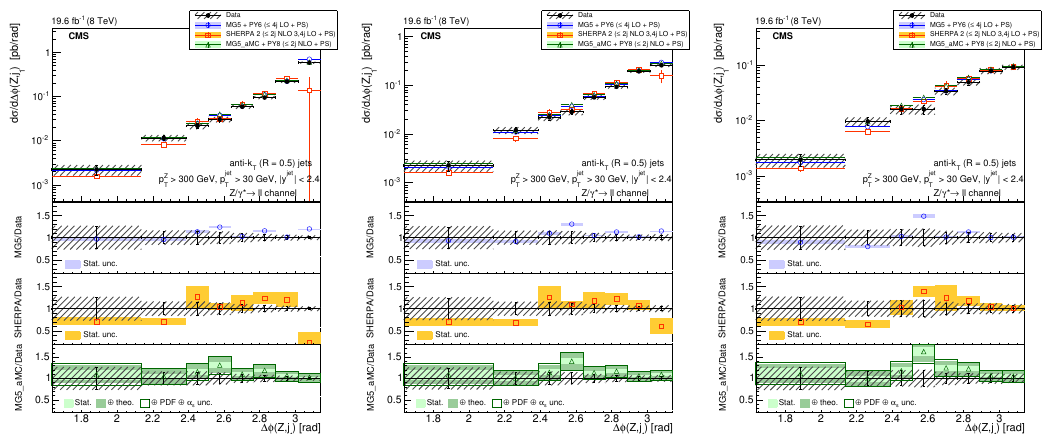
Figure 22 . The di(cid:11)erential cross section as a function of the azimuthal angle between the Z boson and the leading jet, for p T (Z) > 300 GeV and (left) N jets (cid:21) 1, (middle) N jets (cid:21) 2, and (right) N jets (cid:21) 3. The lower panels show the ratios of the theoretical predictions to the measurements. Error bars around the experimental points show the statistical uncertainty, while the cross-hatched bands indicate the statistical and systematic uncertainties added in quadrature. The boxes around the mg5 a mc + pythia 8 to measurement ratio represent the uncertainty on the prediction, in- cluding statistical, theoretical (from scale variations), and PDF uncertainties. The dark green area represents the statistical and theoretical uncertainties only, while the light green area represents the statistical uncertainty